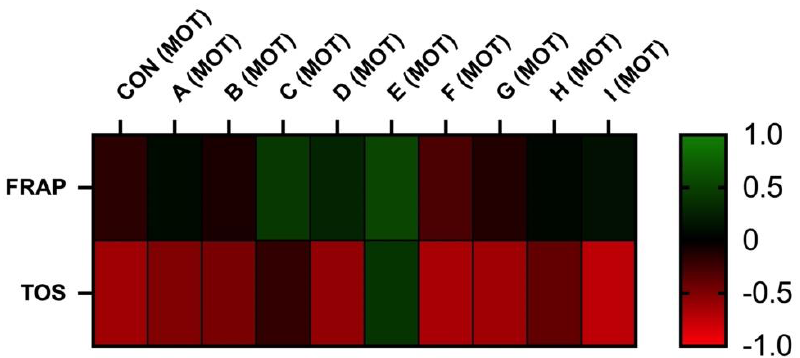
Figure 5. Correlations FRAP vs. MOT and TOS vs. MOT after 30 h of incubation at 5 °C ( n = 10): correlations between FRAP and MOT were determined by comparison of respective experimental concentrations (FRAP (CON) vs. MOT (CON), FRAP (A) vs. MOT (A), FRAP (B) vs. MOT (B), FRAP (C) vs. MOT (C), FRAP (D) vs. MOT (D), FRAP (E) vs. MOT (E), FRAP (F) vs. MOT (F), FRAP (G) vs. MOT (G), FRAP (H) vs. MOT (H), and FRAP (I) vs. MOT (I)), correlations between TOS and MOT were determined by comparison of respective experimental concentrations (TOS (CON) vs. MOT (CON), TOS (A) vs. MOT (A), TOS (B) vs. MOT (B), TOS (C) vs. MOT (C), TOS (D) vs. MOT (D), TOS (E) vs. MOT (E), TOS (F) vs. MOT (F), TOS (G) vs. MOT (G), TOS (H) vs. MOT (H), and TOS (I) vs. MOT (I)).